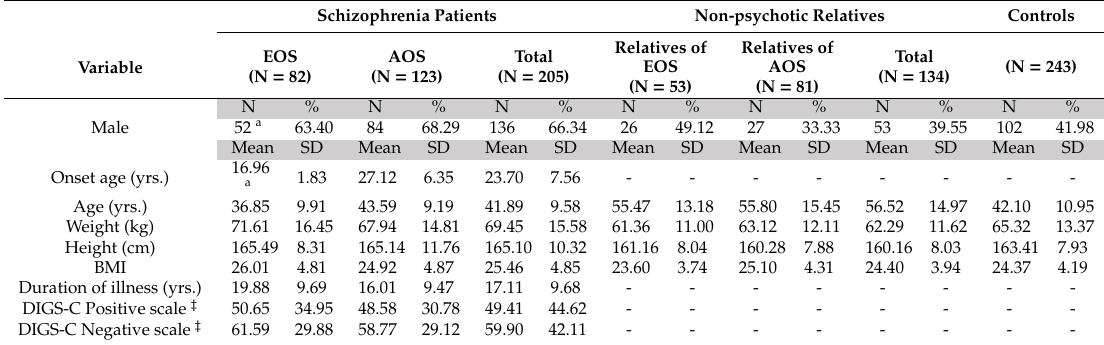
Table 1. Demographic characteristics of schizophrenia patients with di ff erent onset ages, non-psychotic relatives and healthy